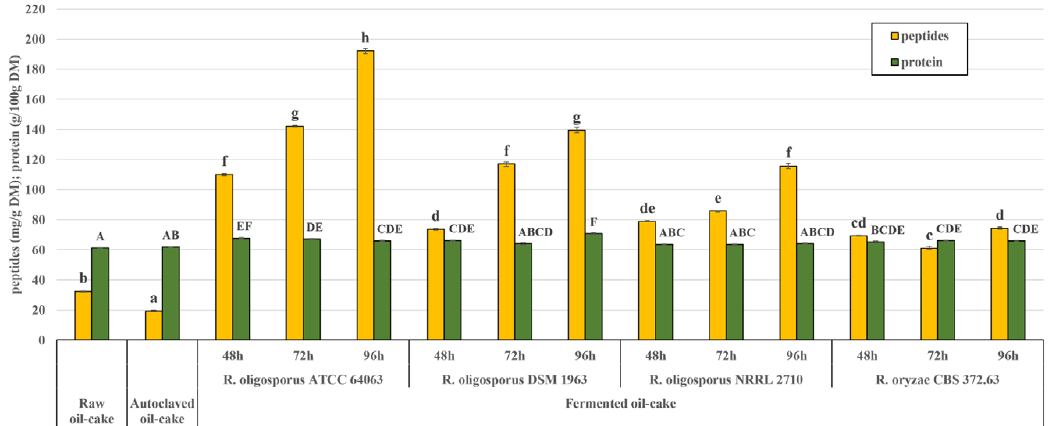
Figure 3. Protein and peptides in pumpkin oil-cake—raw, autoclaved and fermented with Rhizopus strains. One-way analysis of variance and Tuckey post-hoc test were applied. Data is shown as the mean ± SEM. Different letters depict data that differ significantly ( p ≤ 0.05 ) within the parameter.